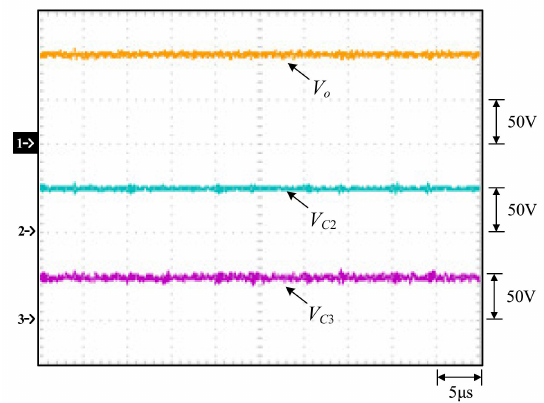
Figure 25. Waveforms measured under the thermoelectric system: (1) V o ; (2) V C 2 ; (3) V C 3 .